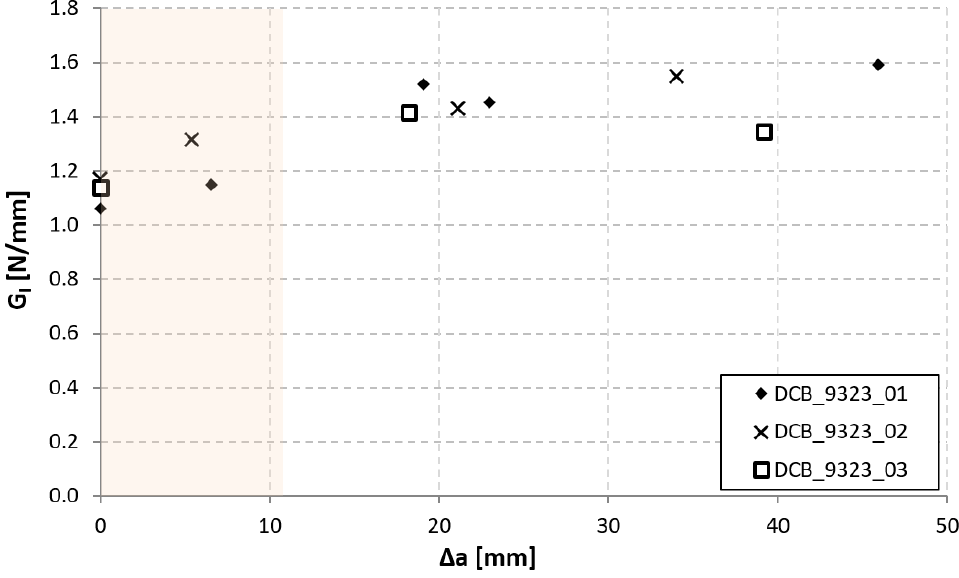
Figure 31. Mode I R-curve of DCB_9323 joints.